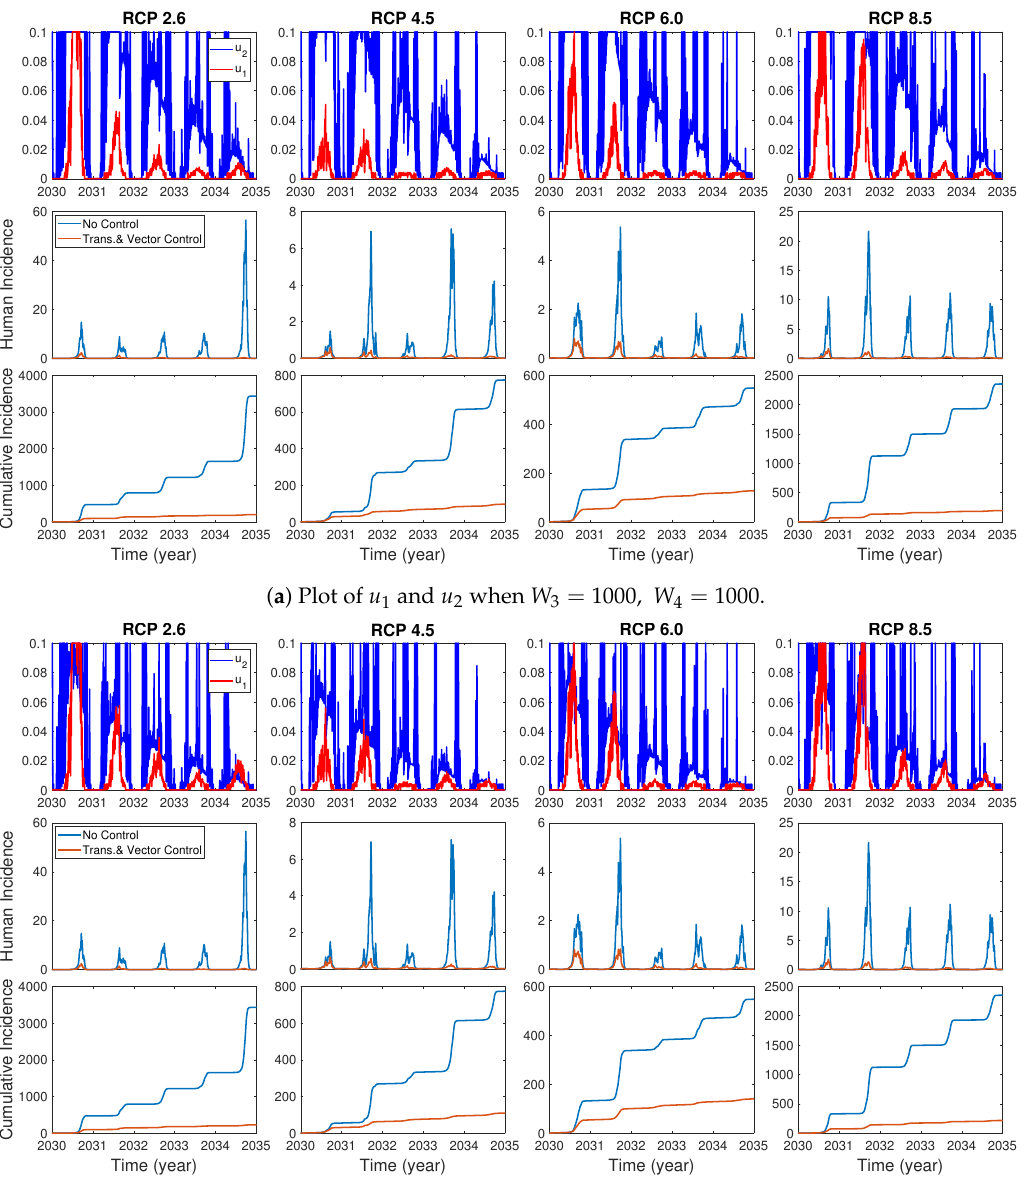
( b ) Plot of u 1 and u 2 when W 3 = 1000, W 4 = 3000. Figure A2. Cont